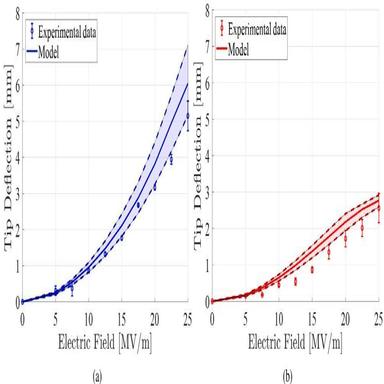
Experimental and model tip deflections for (a) transversally aligned nanofibers integrated in PDMS (b) longitudinally aligned nanofibers integrated in PDMS. The shaded areas represent the simulation results with the relative permittivity values spanned between 9 and 12.